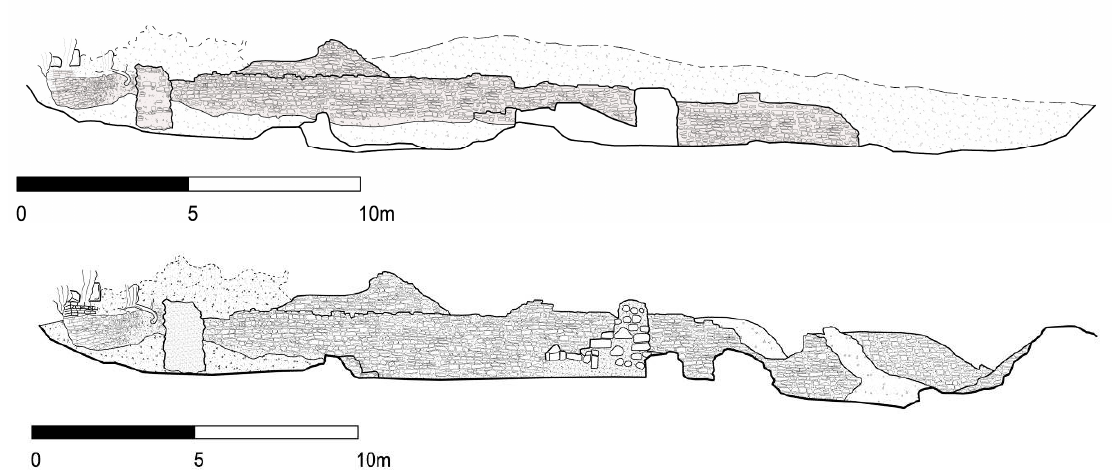
Figure 11. Two sections (AA’, BB’) of the archaeological area derived from the laser scanning